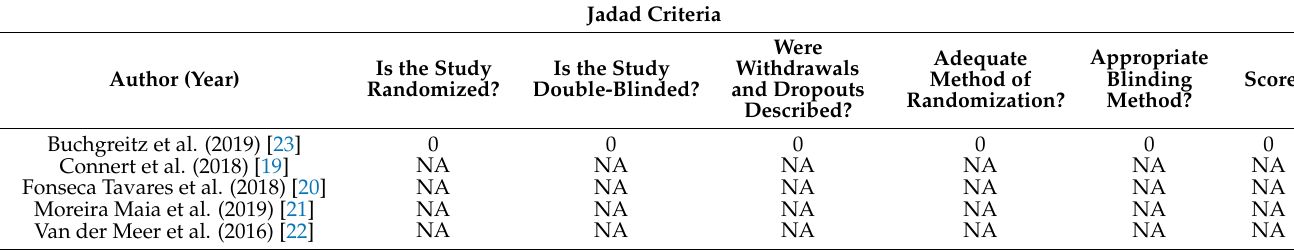
Table 3. Methodological quality assessment using the Jadad